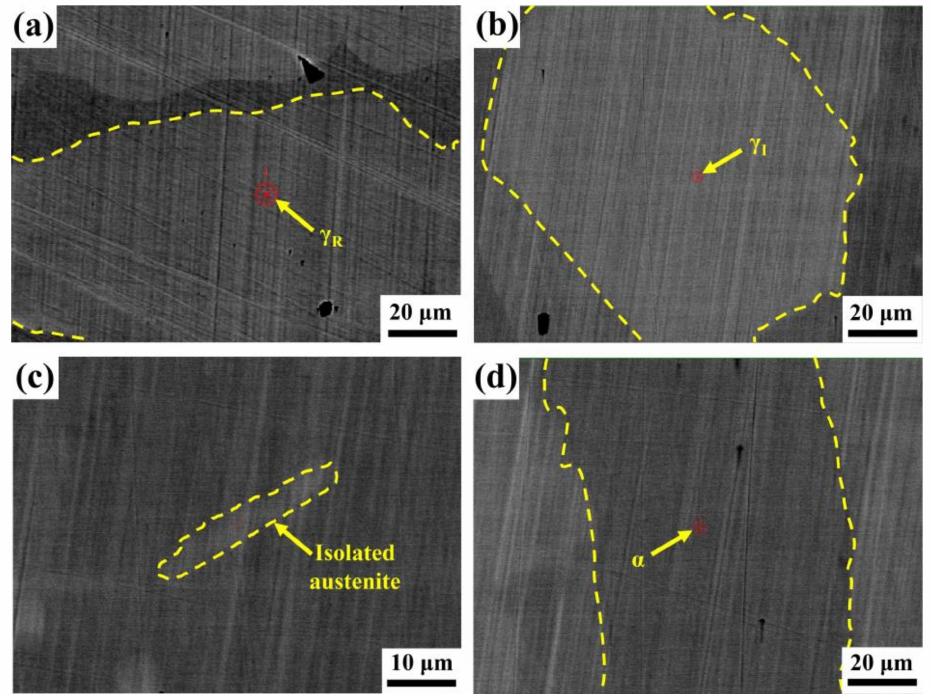
Figure 3. Test points of EPMA: ( a ): γ R ; ( b ): γ I ; ( c ): IA; ( d ): α